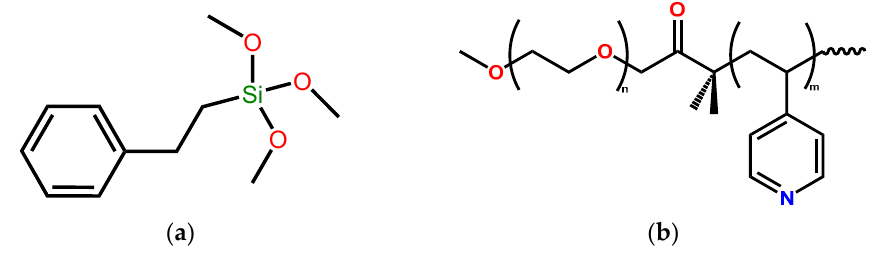
Figure 1. Molecular structure of TMPES ( a ) and P4VP-PEO ( b ).